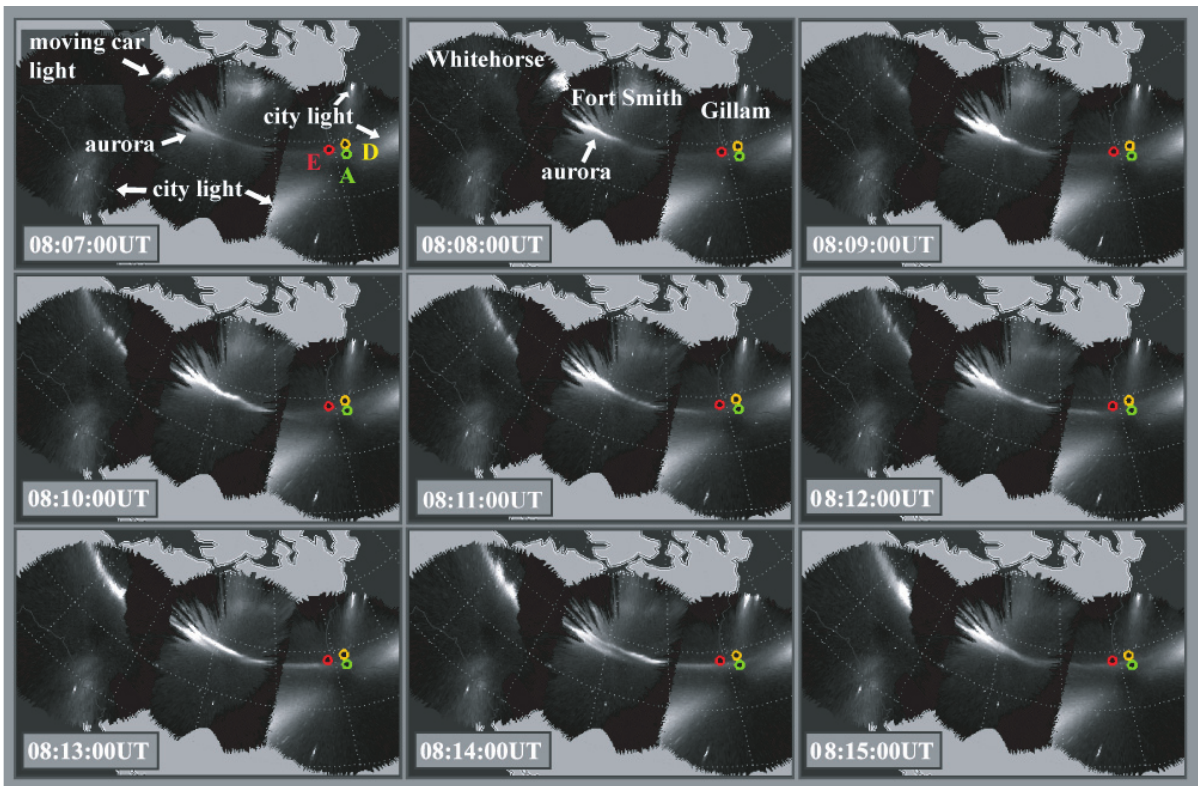
Fig. 1. Mosaic auroral images showing the auroral brightening at the substorm onset, which were obtained at three THEMIS all-sky imaging stations (from left to right, Whitehorse, Fort Smith, and Gillam) at 1-min intervals between 08:07:00UT and 08:15:00UT on 10 January 2008. Yellow, red, and green circles indicate the footprints of THEMIS D (58.7 ◦ N, 267.1 ◦ E), E (58.7 ◦ N, 264.3 ◦ E), and A (57.8 ◦ N, 267.3 ◦ E),